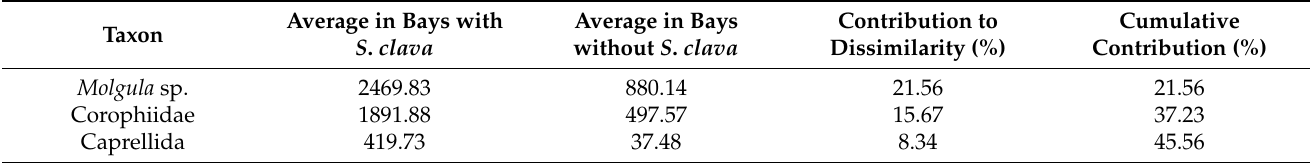
√ Table 5. Results of SIMPER analysis of -transformed mussel sock macroinvertebrate abundance, indicating taxa contributing most to total dissimilarity between assemblages in bays with and without Styela clava .